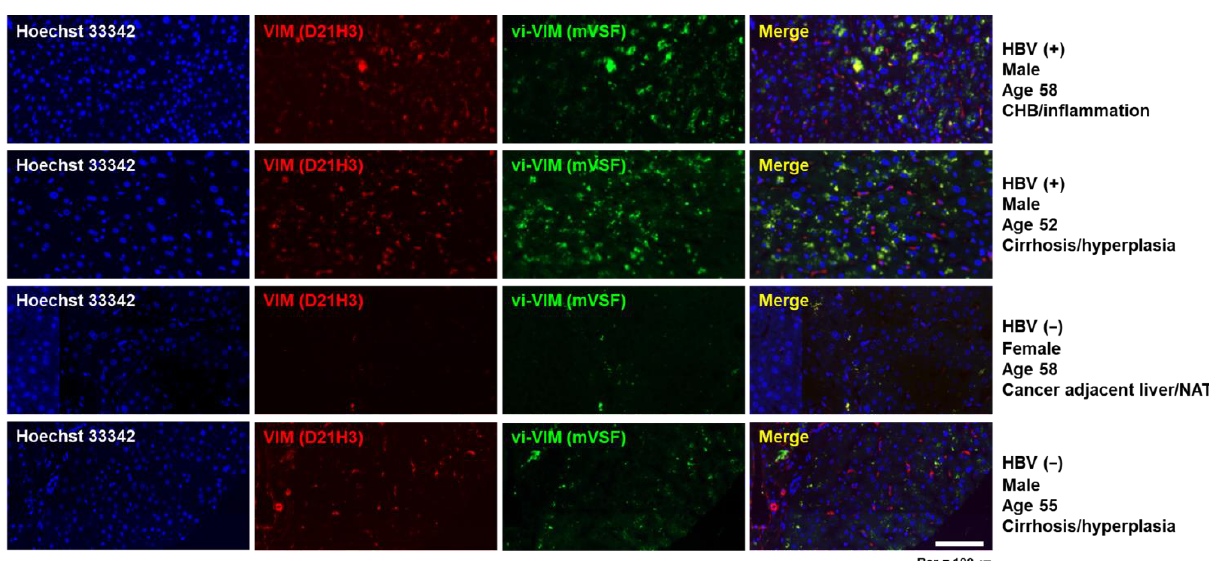
Figure 5. The presence of vi-VIM is strongly increased in HBV-infected liver. A human liver tissue array was used for detecting changes in the presence of intracellular VIM (red color) and vi-VIM (green color) by immunofluorescence staining with D21H3 or mVSF antibodies, respectively. Merging of both stains (yellow color) indicated a perinuclear colocalization of intracellular VIM and vi-VIM in many hepatocytes. Hoechst 33,342 staining was used to detect cell nuclei (blue color). Representative pictures of two HBV-infected and two HBV-uninfected livers are shown. Abbreviation: NAT, nonalcoholic liver tumor.